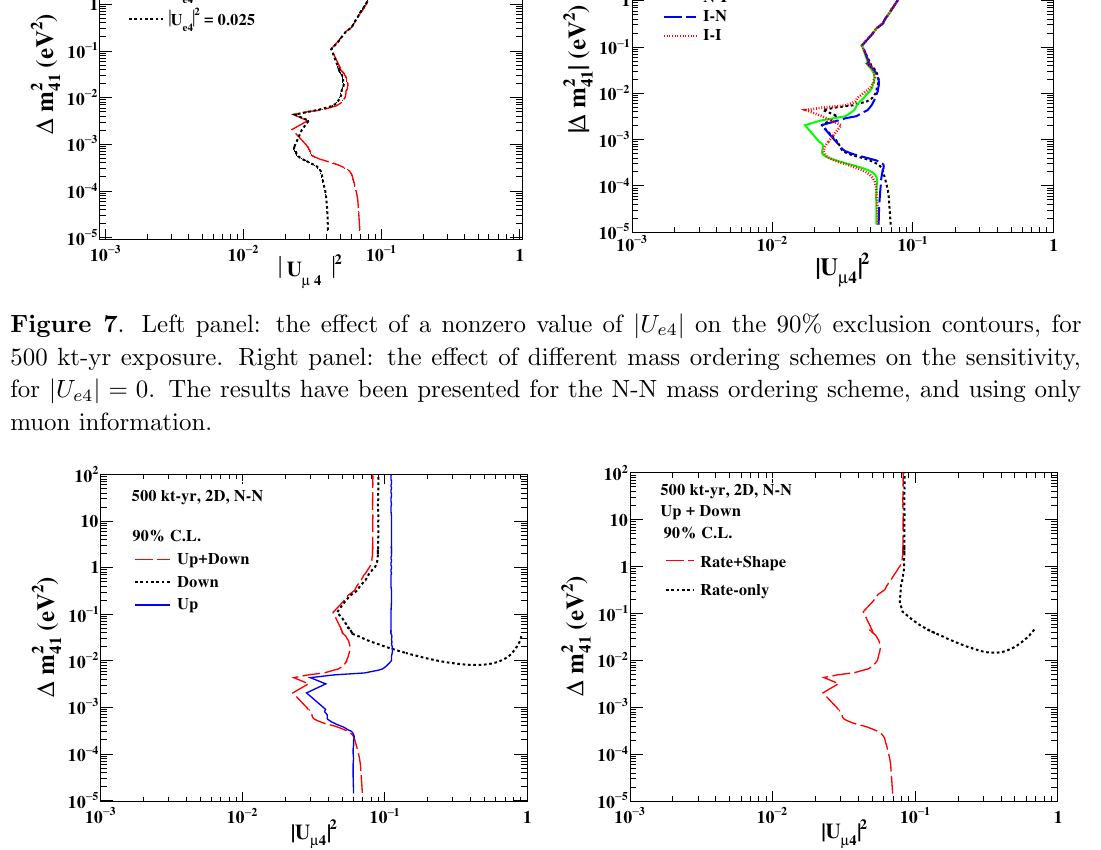
Figure 8 . Left panel: 90% C.L. exclusion regions in the j U (cid:22) 4 j 2 {(cid:1) m 2 plane with up-going events 41 and down-going events separately, as well as their combined e(cid:11)ect. Right panel: 90% C.L. exclusion regions in the j U (cid:22) 4 j 2 {(cid:1) m 2 plane using the information on both the rate and shape of the muon 41 spectrum, and using the information only on the rate of muon events (integrated over the range [1{11] GeV and over all the directions). The results have been presented for the N-N mass ordering scheme, and using only muon